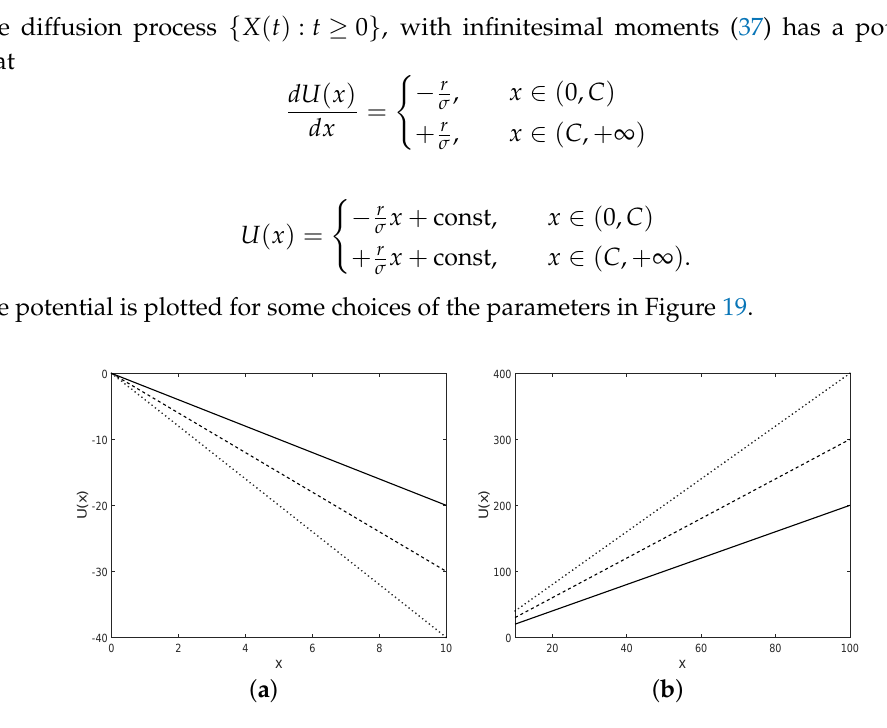
Figure 19. The potential U ( x ) is plotted for x ∈ ( 0, C ) in ( a ) and for x ∈ ( C , + ∞ ) in ( b ) and for C = 10, r = 1, y = 1 and σ = 1/2 (solid line), σ = 1/3 (dashed line), σ = 1/4 (dotted line), with the initial condition U ( 0 ) =